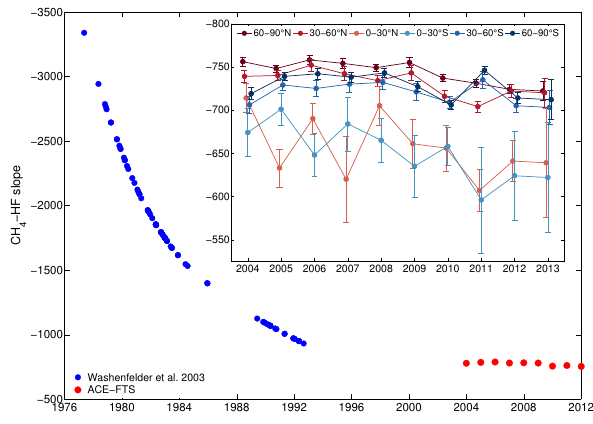
Figure 2. Long-term CH 4 –HF slopes derived by Washenfelder et al. (2003) and annual-mean slopes from ACE-FTS measurements. The inset shows the time series of zonal pressure-weighted ACE-FTS slopes ( β ), with error bars denoting the 2 σ standard error. For each year, zonal slopes are offset from each other for